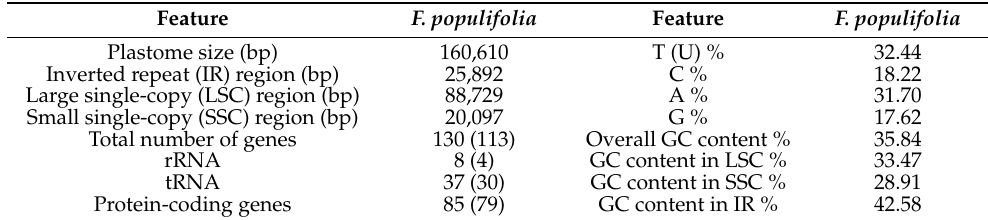
Figure 2. Map of the plastome of Ficus populifolia . The inner dark and light grey circle represent GC and AT content, respectively. Different colours distinguish functional sets of genes, with those outside the circle transcribed counter-clockwise and those inside transcribed clockwise. Genes marked with * have introns. Table 1. Features of Ficus populifolia Vahl.